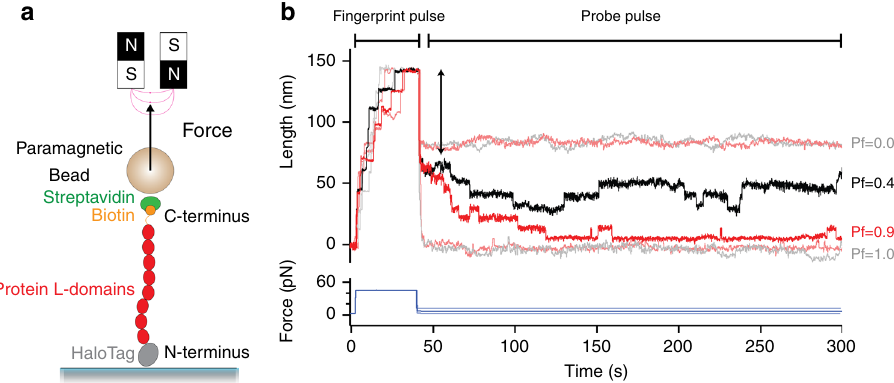
Fig. 1 Trigger factor and the folding dynamics of protein L. a Schematics of the magnetic tweezers experiment, showing the octamer of protein L tethered between a glass coverslip and the paramagnetic bead. The force is applied by changing the separation of the permanent magnets and the bead. b Dynamics of protein L octamer at three different forces with ( red ) and without ( black ) TF. First, the protein is fully unfolded by a fi ngerprint pulse, where the eight unfolding events are identi fi ed as eight length steps. Second, a refolding pulse is set at a lower force (4.3, 7.4 and 11.9 pN, from bottom to top ). At 4.3 pN ( faint color , lowest length) all domains are able to fold by themselves, leading to a maximum probability of folding. Therefore, TF does not do any signi fi cant effect. At 11.9 pN ( faint color , highest length), the protein is not able to refold (0 probability of folding) and TF does not either affect the probability of folding. In the intermediate force range (7.4 pN, solid colors ) TF greatly increases the probability of folding, re fl ected in a higher number of folded